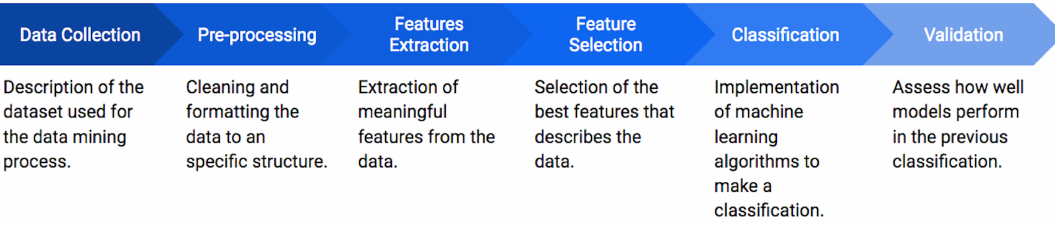
Figure 1. Data mining process used in this paper to classified depressive and non-depressive